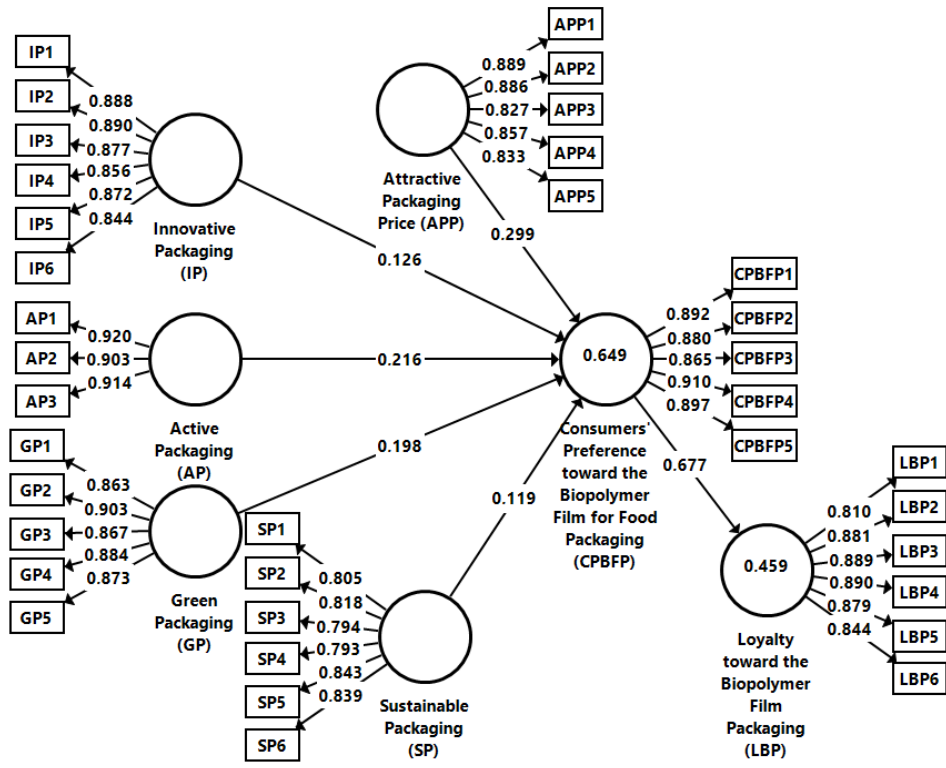
Figure 4. Structural model.